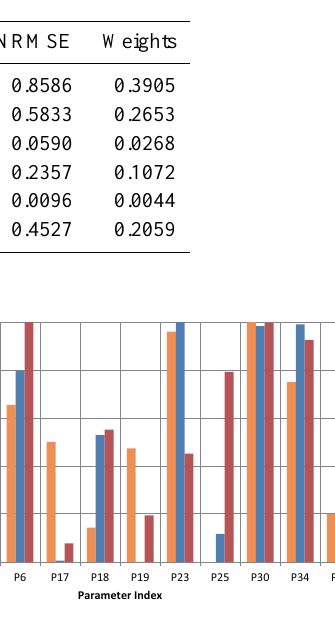
Table 4. Weights assigned to each output variables (weighting system case 1).